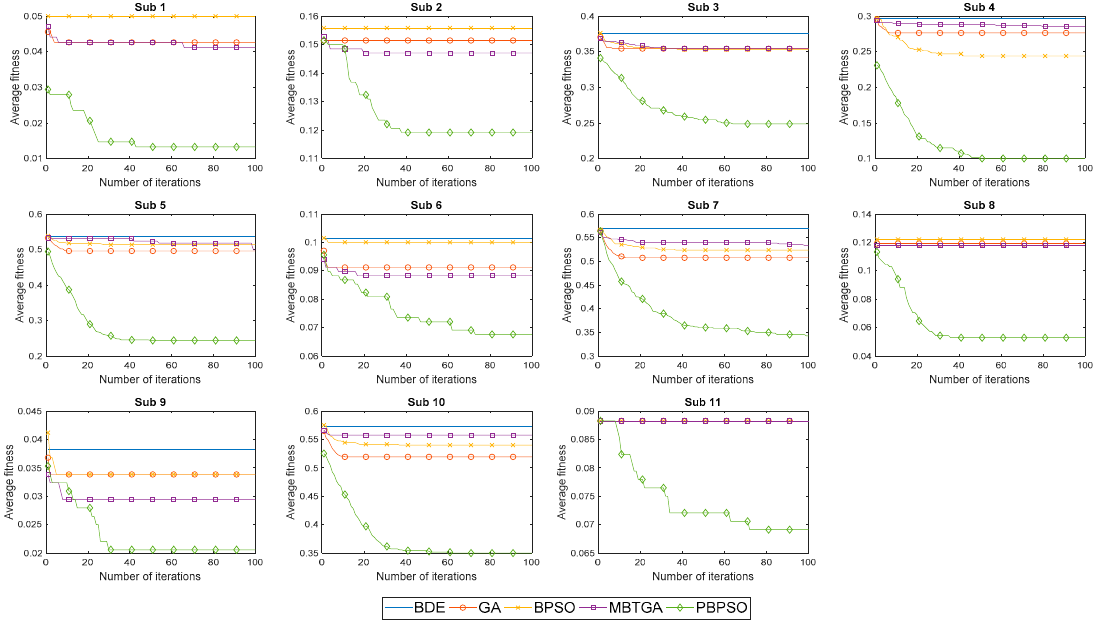
Figure 5. Convergence curve of five different feature selection methods for 11 subjects.